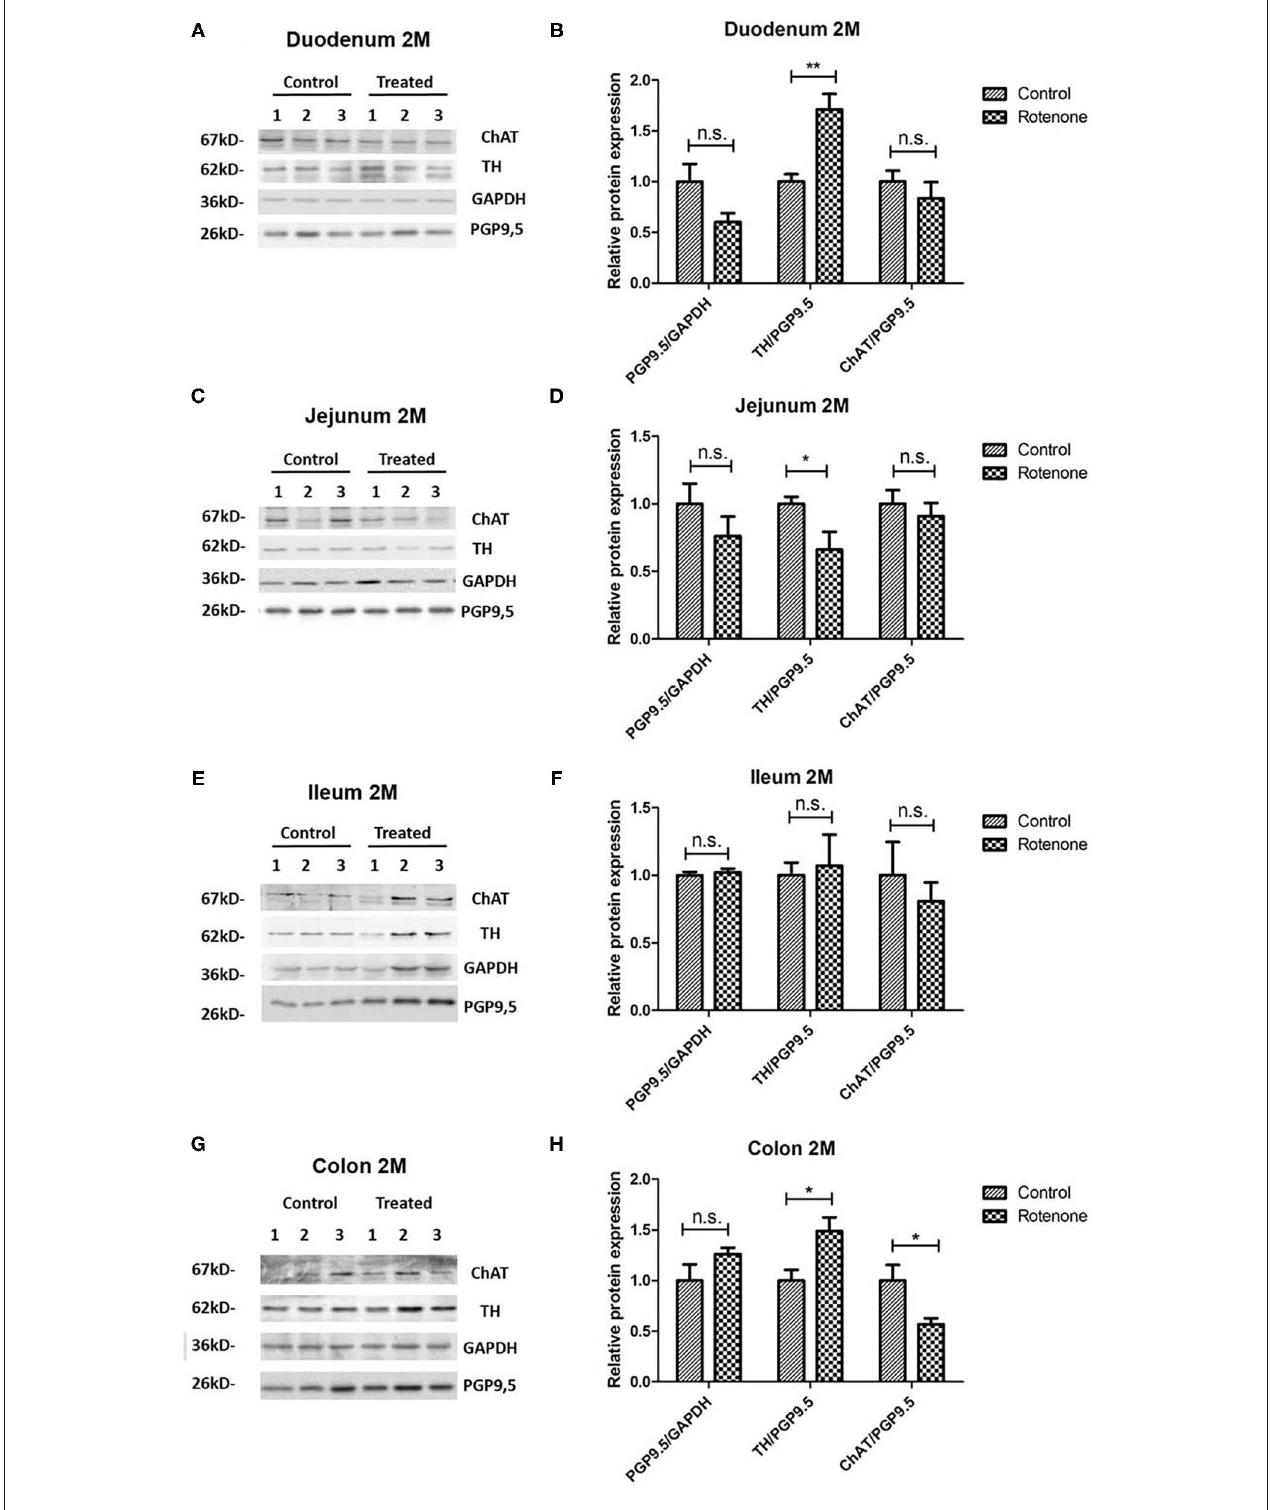
FIGURE 12 | Effect of 2-month rotenone on the expression of ChAT, TH, and PGP9.5 in each intestinal region. Western blots in (A,C,E,G) show three representative examples per exposure group for the protein levels of ChAT, TH, GAPDH, and PGP9.5 in duodenum (A) , jejunum (C) , ileum (E) , and colon (G) . The protein